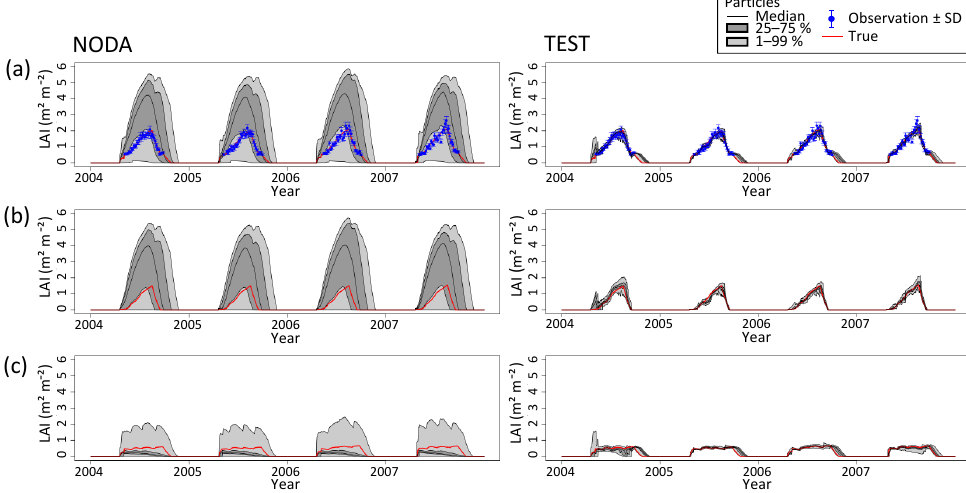
Figure 3. Time series of LAI for (a) tree plus grass, (b) tree, and (c) grass for an experiment without DA (NODA, left) and an experiment with DA (TEST, right). Dark and light gray areas indicate the quartiles and 1–99% quantiles of the particles as shown in the legend. Thick black curves indicate the medians. Blue dots with error bars indicate the observations and their error standard deviations, and red lines indicate the nature